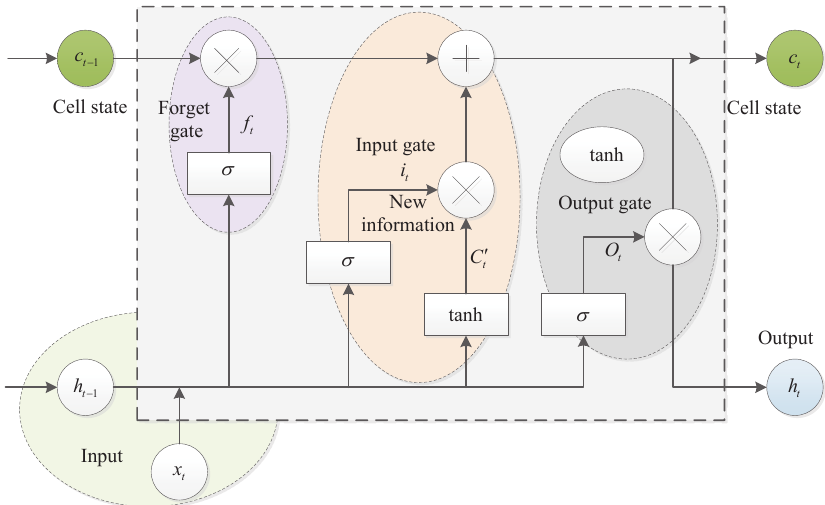
Figure 2. The structure of the LSTM neural